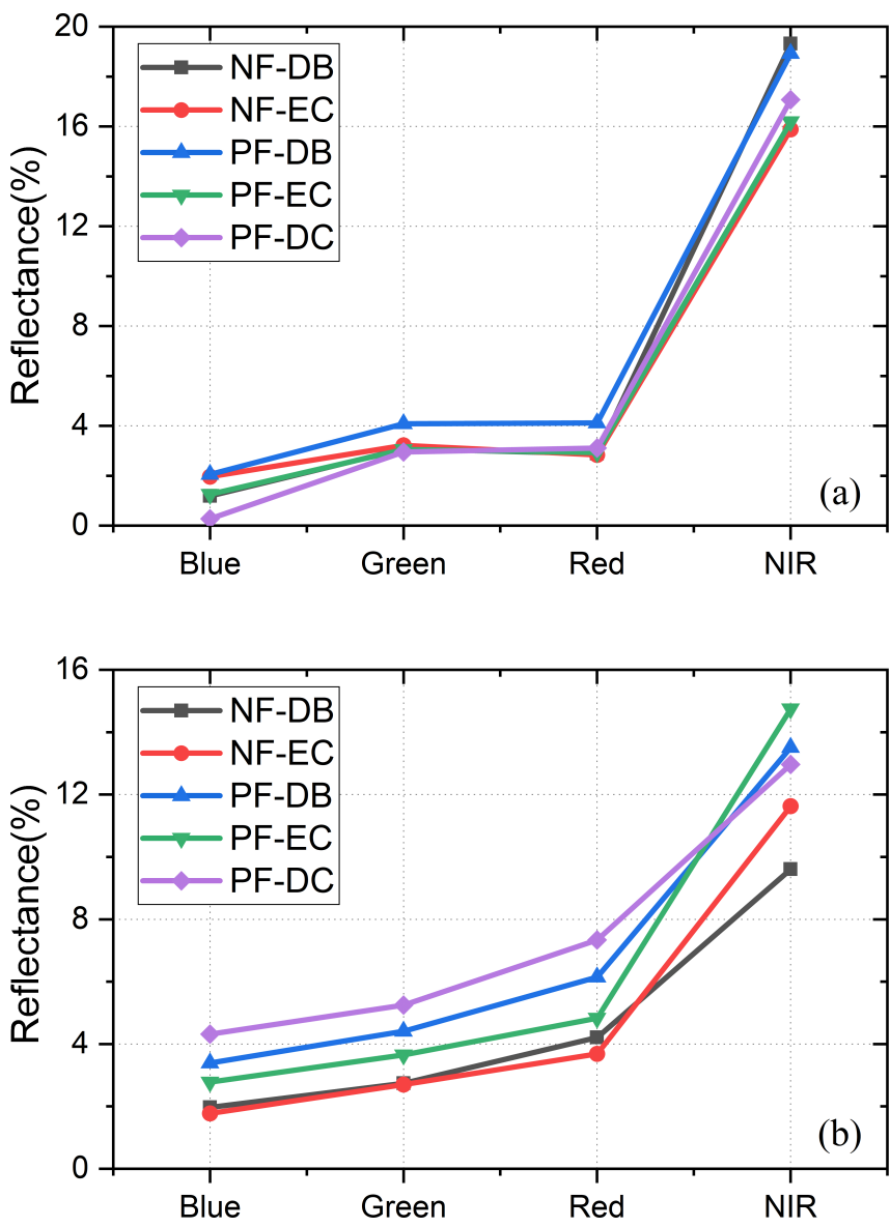
Figure 3. Mean reflectance of five forest types from GF-1 WFV bands: ( a ) Summer; ( b ) Winter. NF-DB: natural deciduous broad-leaved forest; NF-EC: natural evergreen coniferous forest; PF-DB: deciduous broad-leaved plantation; PF-EC: evergreen coniferous plantation; PF-DC: deciduous coniferous plantation.